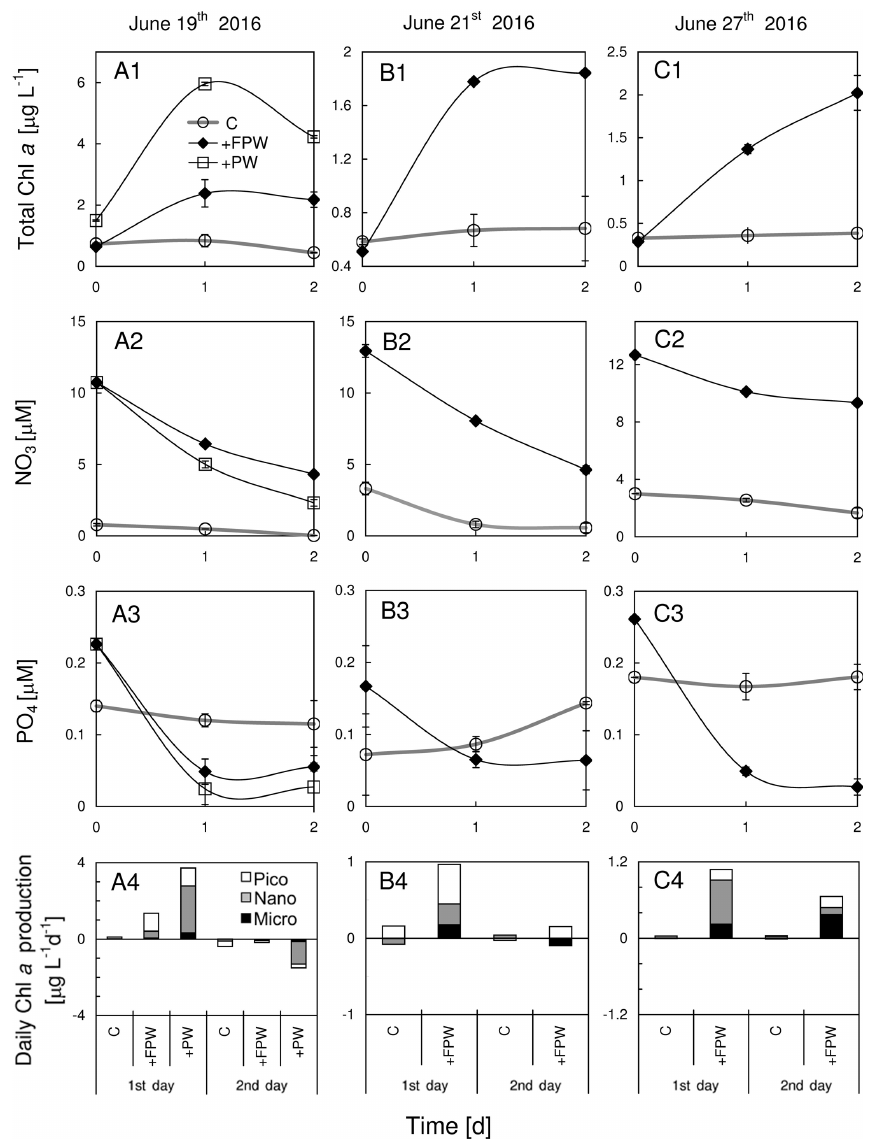
Figure 8. Responses of total chlorophyll a , nitrate, phosphate and size-fractionated rate of daily chlorophyll a production in the surface water to the addition of plume water at (a1)–(a4) S6, (b1)–(b4) S7 and (c1)–(c4) S8. PW is the plume water with FPW the filtered plume